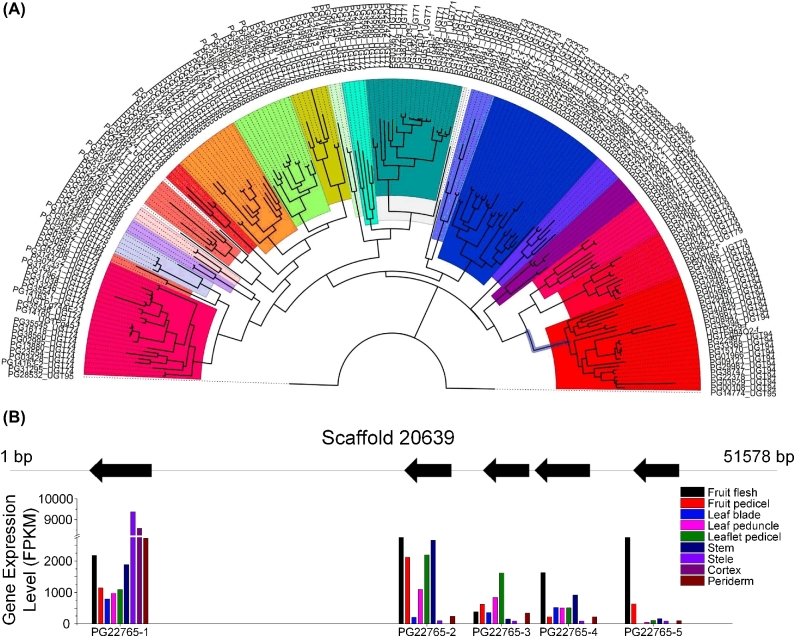
Analysis of UGTs from P. ginseng. (a) All the identified UGTs, which were newly classified according to the standardization of the UGT Nomenclature Committee, were assigned to 24 subfamilies. (b) The expression (lower) of UGT gene copies (PG22765) from the same scaffold (upper) in the different tissues of P. ginseng.